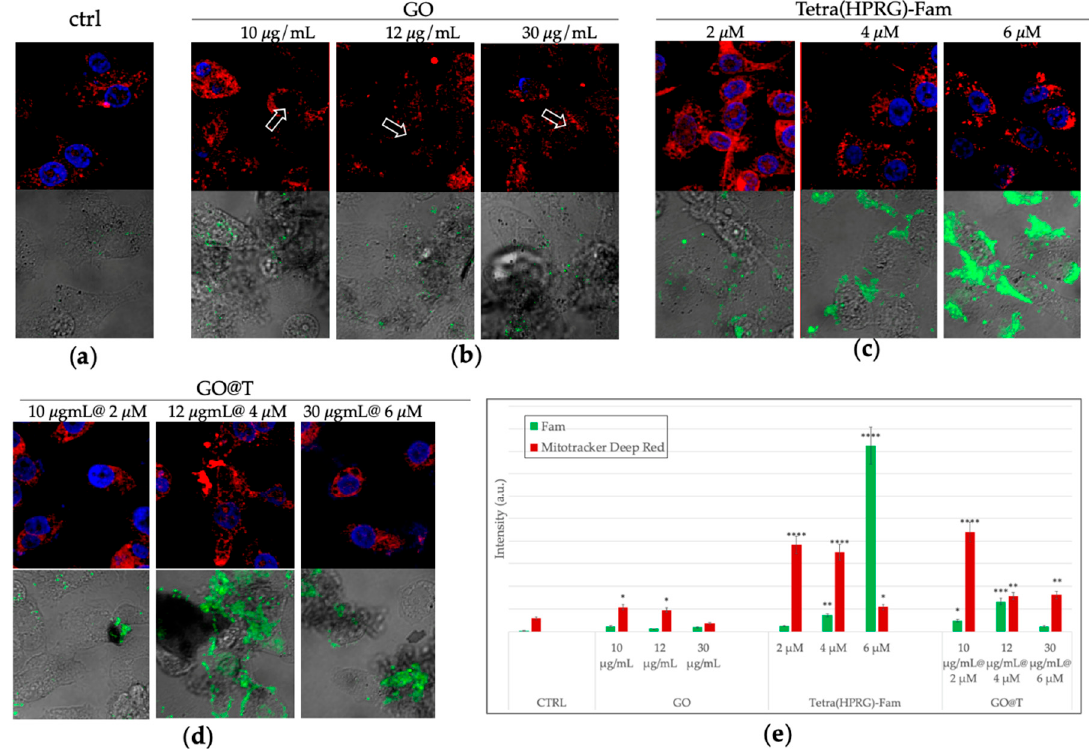
Figure 8. Laser scanning microscopy (LSM) micrographs of PC-3 cells incubated for 24 h in absence ( a : CTRL) or in presence of the different treatments: GO nanosheets ( b : 10, 12, 30 µg/mL), Tetra(HPRG)-Fam peptide ( c : 2, 4, 6 µM) and hybrid GO@T samples ( d : 10 µg/mL-2 µM, 12 µg/mL-4 µM, 30 µg/mL-6 µM of GO-peptide concentration). For each treatment condition, the merged confocal images of nuclei (Hoechst, λ ex/em = 405/425–450 nm) and mitochondria (MitoTracker Deep Red, λ ex/em = 633/650–700) (upper panel), and the merged fluorescence image of the dye-labelled peptide (Fam, λ ex/em = 543/550–600 nm) and the optical bright field micrograph (lower panel) are shown. Scale bar 30 µm. The white arrows guide the eye to the GO sheets. In ( e ): quantitative analysis of Fam and MitoTracker Deep Red emission intensity. Results are presented as mean +/-SEM from experiments in triplicate and normalized with respect to the control untreated cells. Asterisks represent the correlation significant at the (*) p < 0.05, (**) p < 0.01, (***) p < 0.001 (****) p < 0.0001 vs. CTRL, (One-way ANOVA).